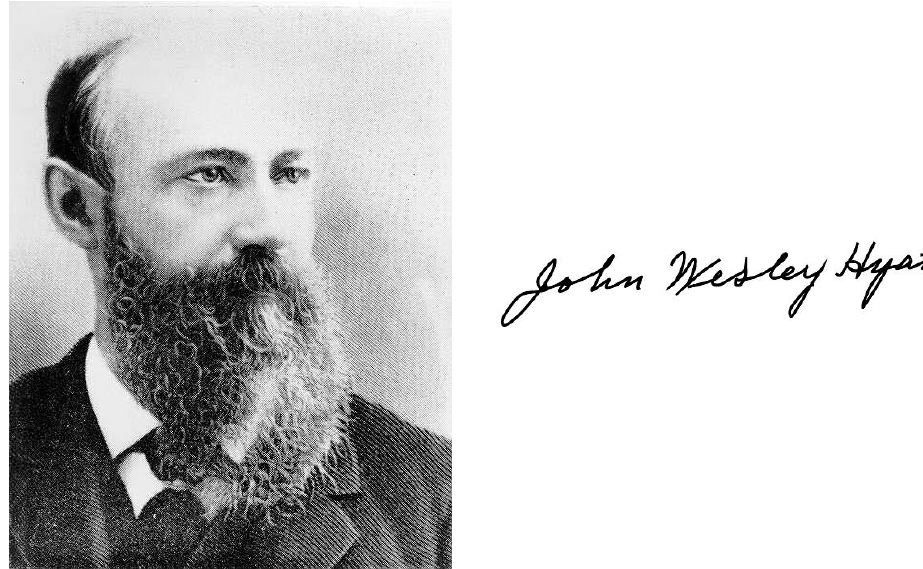
Figure 1. John Wesley Hyatt (1837–1920), American inventor of the first injection molding machine.